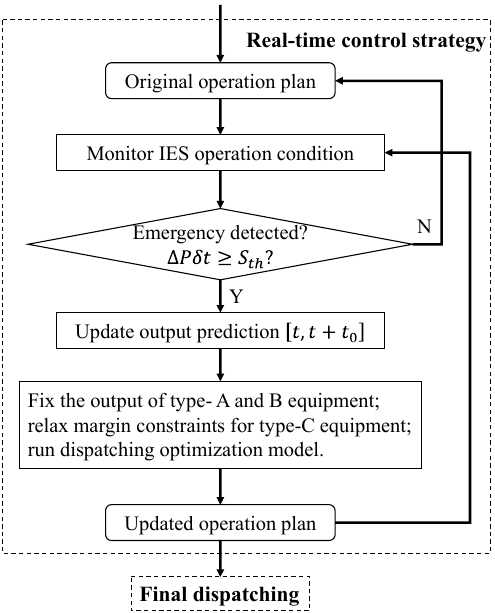
Figure 5. Illustration of real-time control strategy.